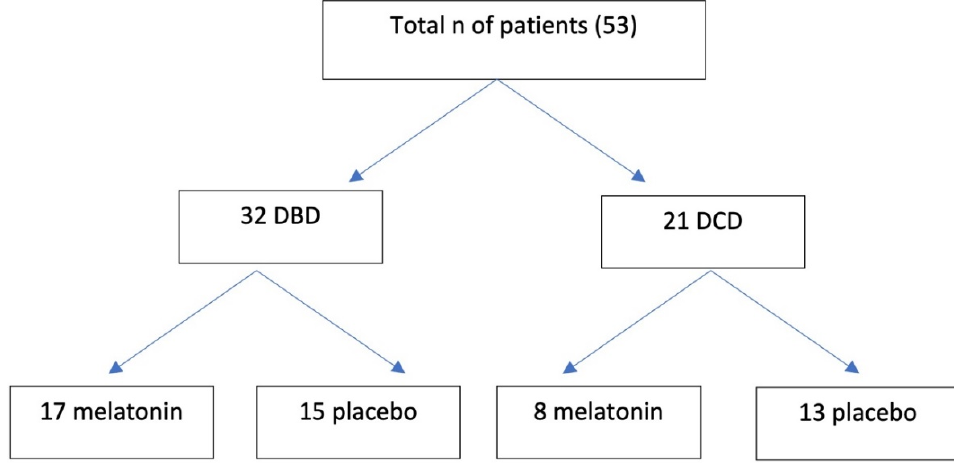
Figure 3. Distribution of the patients included in the study. n: number; DBD: Donation after brain death; DCD: donation after circulatory death.